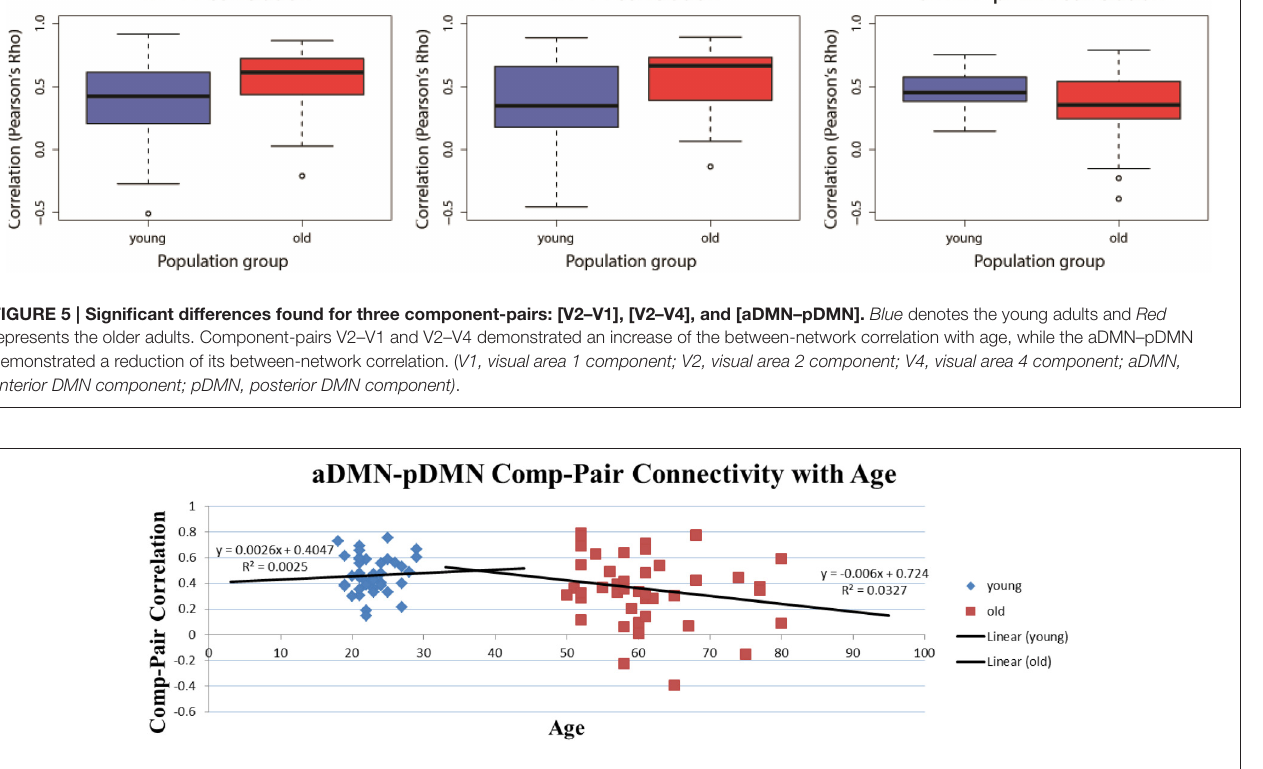
FIGURE 6 | Correlation of Age and Comp-pair Connectivity. Though not significant and for illustrative purpose only, this plot presents a difference in the trajectory of the comp-pair connectivity with age, with an positive slope in the young adults and a negative slope in the older